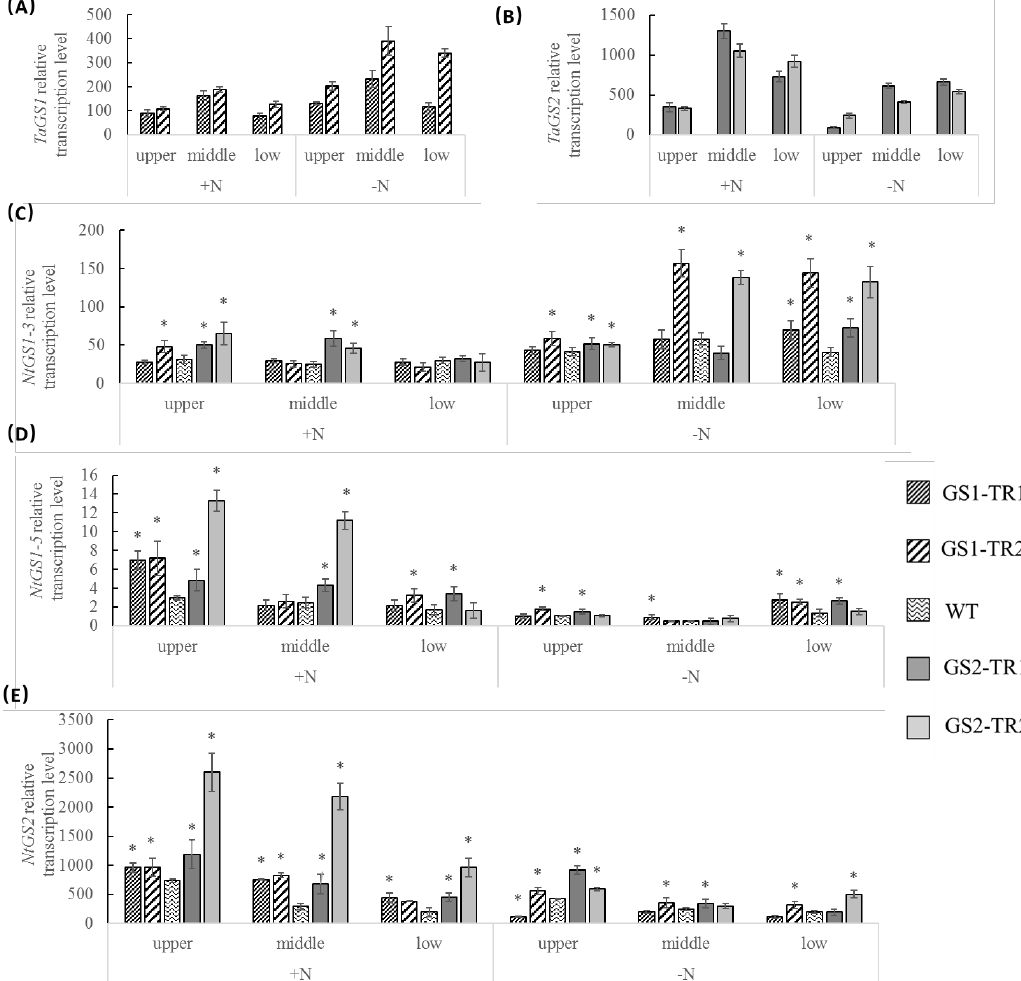
Figure 1. Relative transcription levels of Triticum aestivum glutamine synthetase (GS) TaGS1 ( A ), TaGS2 ( B ), Nicotiana tabacum glutamine synthetase (GS) NtGS1-3 ( C ), NtGS1-5 ( D ) and NtGS2 ( E ) in the upper, middle, and lower leaves of transgenic plants grown under nitrogen-sufficient (N+) and nitrogen-starvation (N − ) conditions. Data are means of three independent biological replicates ± standard deviation (SD). Asterisks indicate that the data is significantly different ( p < 0.05) from the data of wild type (WT)